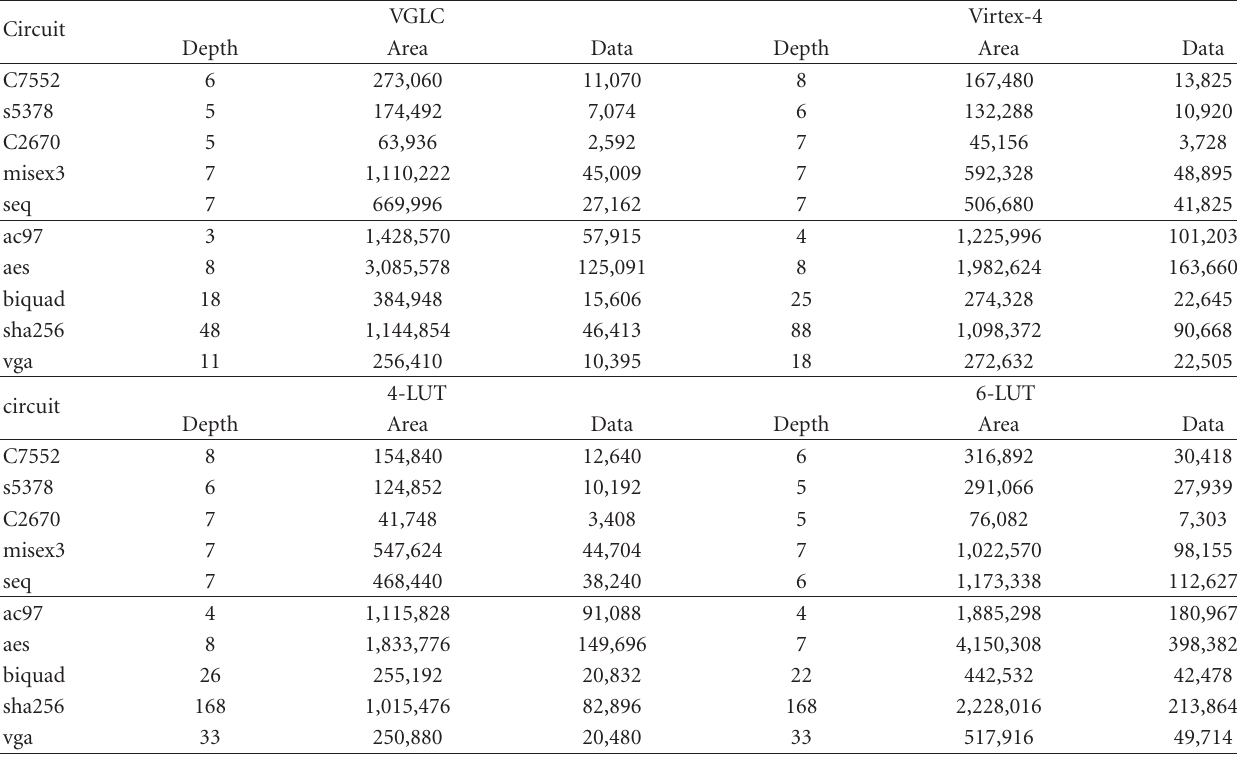
Table 6: Logic depth, area, and data for di ff erent architectures.